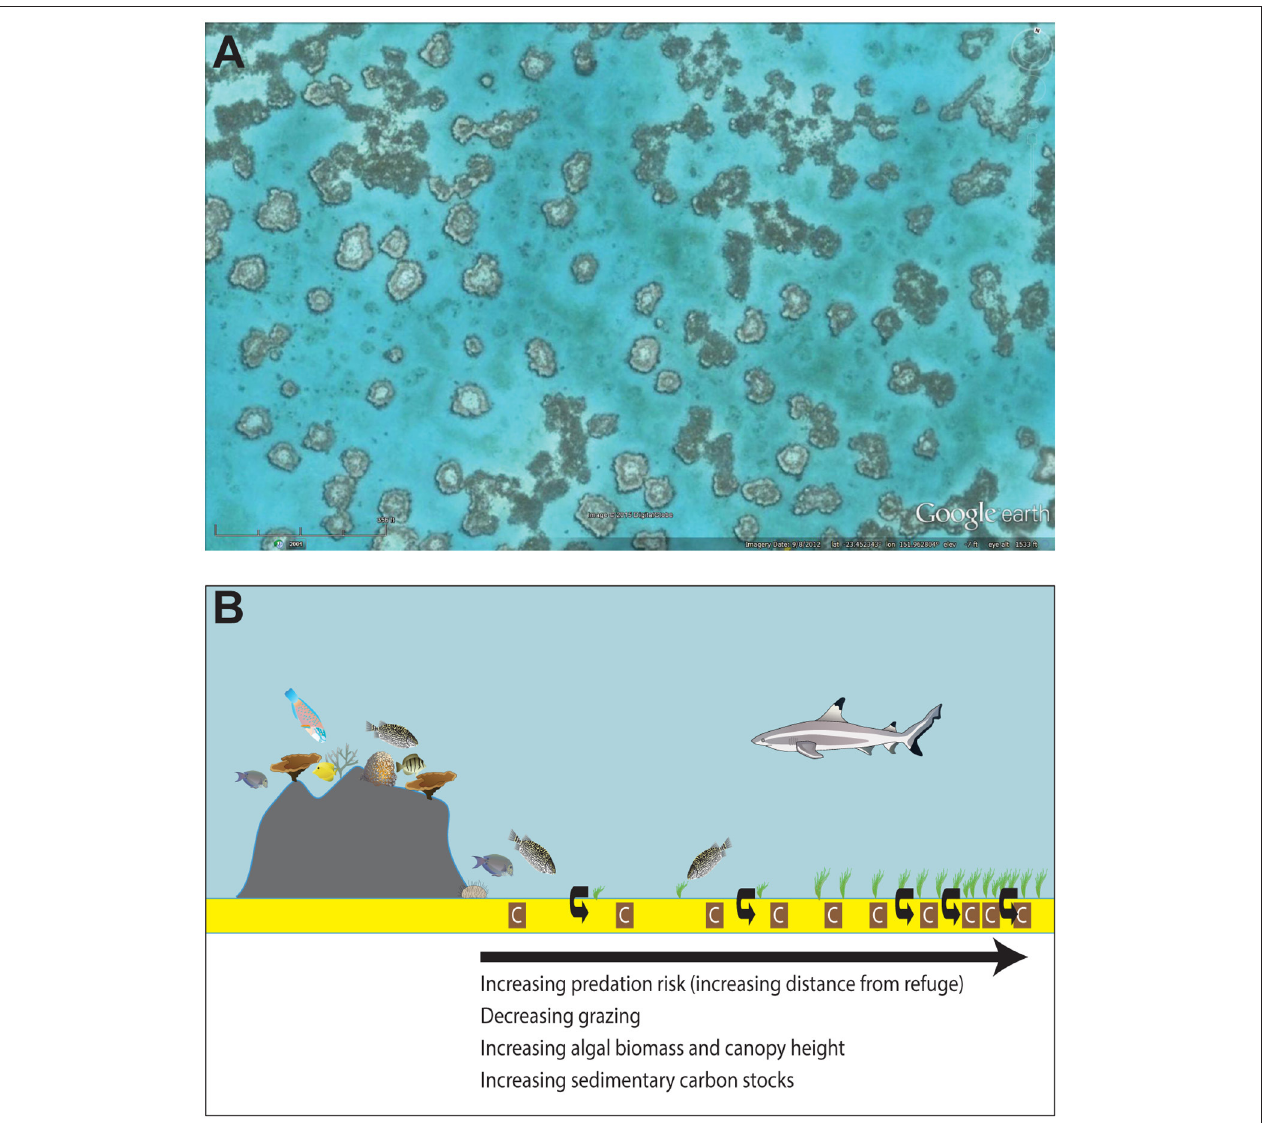
FIGURE 1 | Grazing halos. (A) Satellite image of macroalgal “grazing halos” in Australia’s Heron lagoon. Image copyright Digital Globe and Google Earth. (B) Hypothesized non-consumptive effects of predators on grazing intensity, algal biomass, and sedimentary carbon stocks. The risk of predation constrains herbivore abundance to areas close to the reef, leading to reduced grazing, increased algal biomass, and increased sedimentary carbon stocks (brown boxes with “C”) and sequestration (curved, black arrows) with increasing distance from reef refuges.